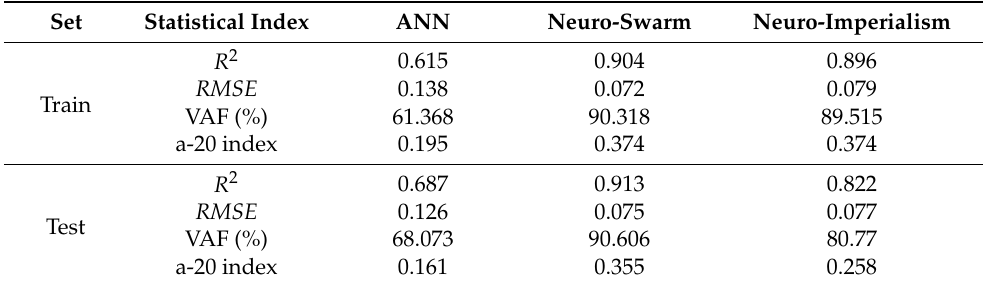
Table 3. Results of the developed models in forecasting PPV values.